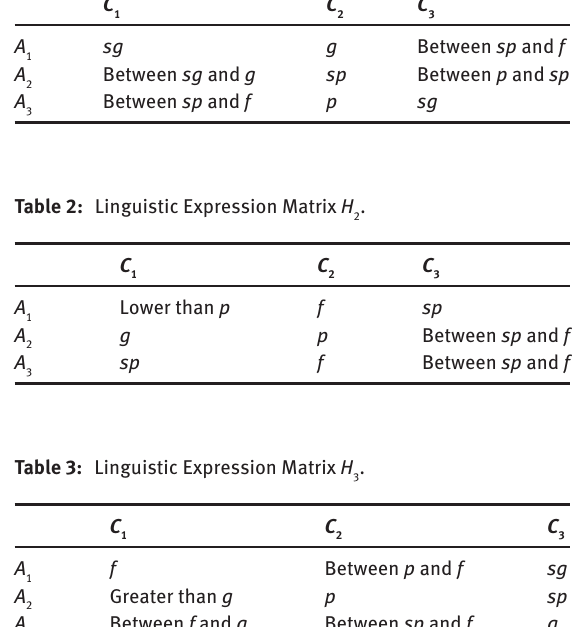
Table 1: Linguistic Expression Matrix H